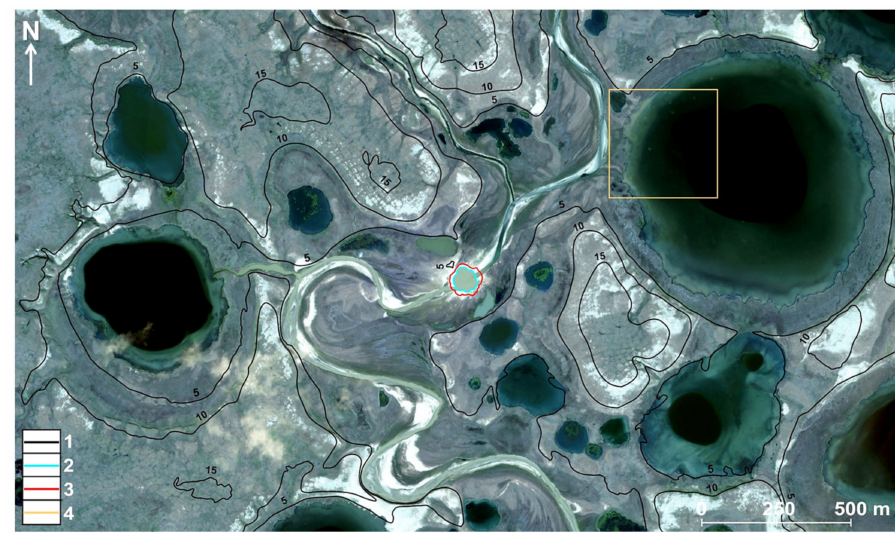
Figure 2. Satellite image from 27 June, 2017 (WorldVeiw-3, ESRI) and the location of Seyakha Crater C11. Legend: 1—surface contour lines (m); 2 and 3—contours of crater on 27 June 2017 and on 11 August 2020; 4—the area at the lake bottom with